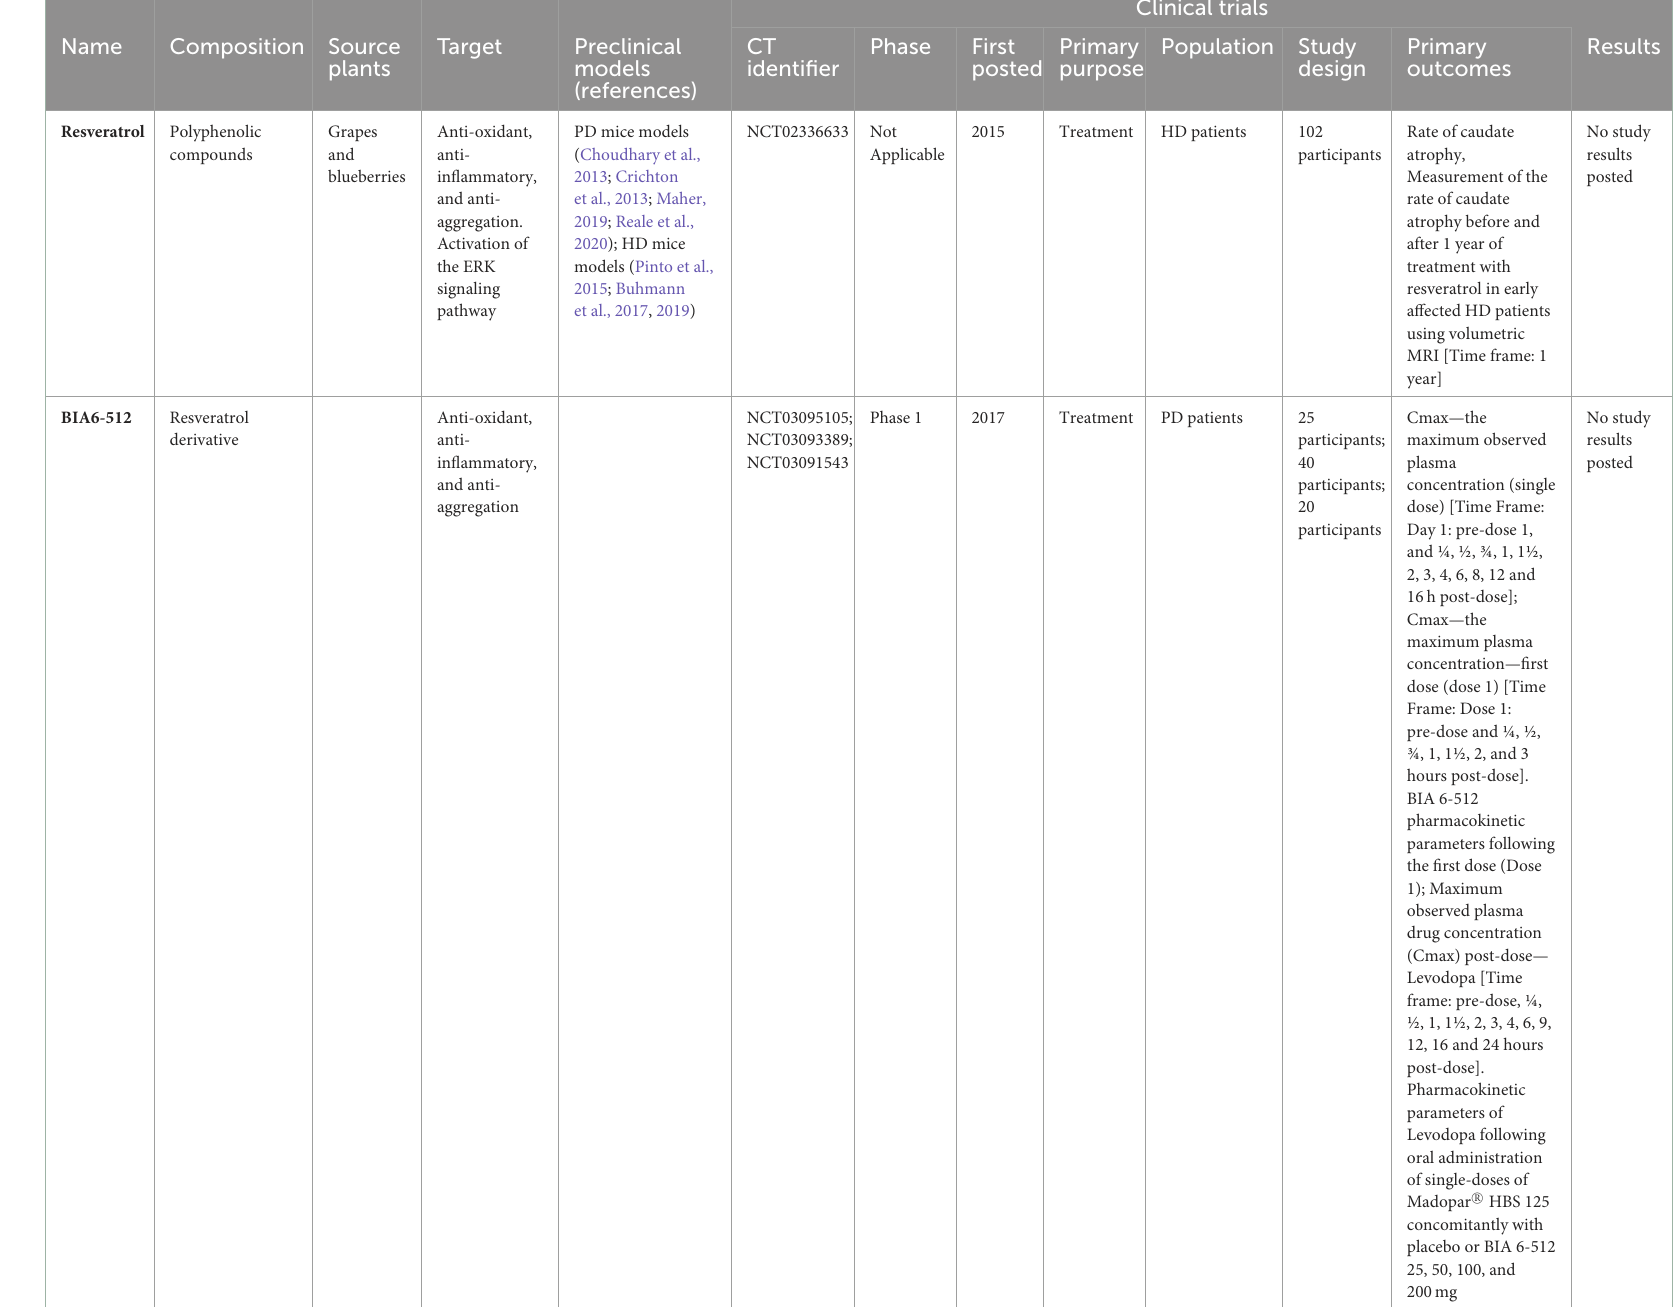
TABLE 2 Description of small molecules from natural sources used in Parkinson’s disease or Huntington’s